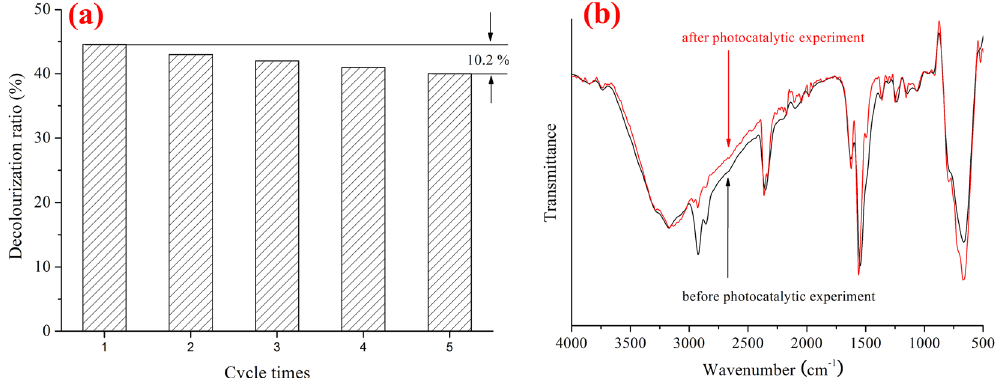
Figure 10. ( a ) The photocatalytic degradation rate of MB with the P/T(1/4) nanocomposite for different recycling times and ( b ) the FT-IR spectra of P/T(1/4) before and after the photocatalytic